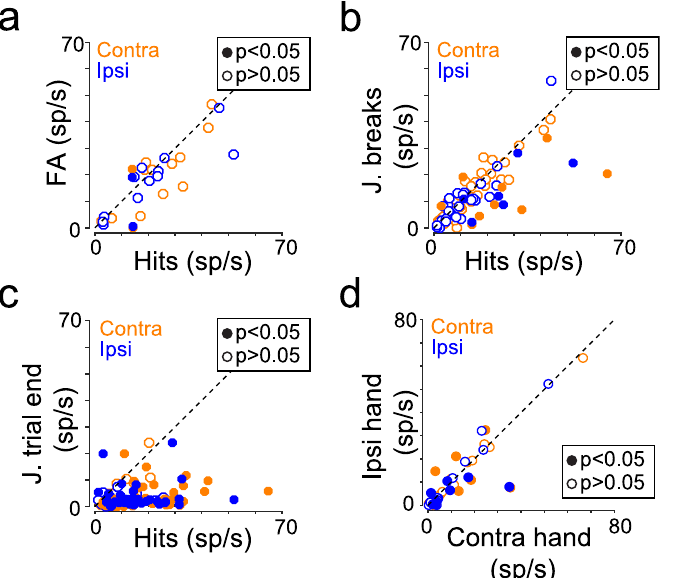
Fig 5. Error trials and hand influence. (A, B, C) Scatter plots of mean caudate activity during FAs (A), joystick breaks (“J. breaks”) (B), and joystick trial end (“J. trial end”) (C) as a function of mean activity to hits for contralateral trials (“Contra”, orange) and ipsilateral trials (“Ipsi”, blue). Filled dots (orange or blue) indicate when mean activities were significantly different (Wilcoxon rank sum test, p < 0.05, corrected with the Holm’s variant of the Bonferroni method). Dashed lines represent identity lines. Joystick breaks are defined as trials when the animals released the joystick but there was no MC event at either stimulus location and joystick trial end as joystick releases at the end of correct reject trials, when the animal was obliged to release the joystick in order to end the trial. We performed these analyses on response-choice neurons for which we recorded at least five trials for each condition (FA, joystick breaks, or joystick trial end). (D) Scatter plot of mean responses for contralateral and ipsilateral hits (orange and blue) computed during the 0.3-s time period when animals used either their ipsilateral hand (y-axis) or contralateral hand (x-axis) with the joystick. Same convention as A, B, and C. Underlying data available in S1 Data. FA, false alarm; MC, motion change; sp/s, spikes per